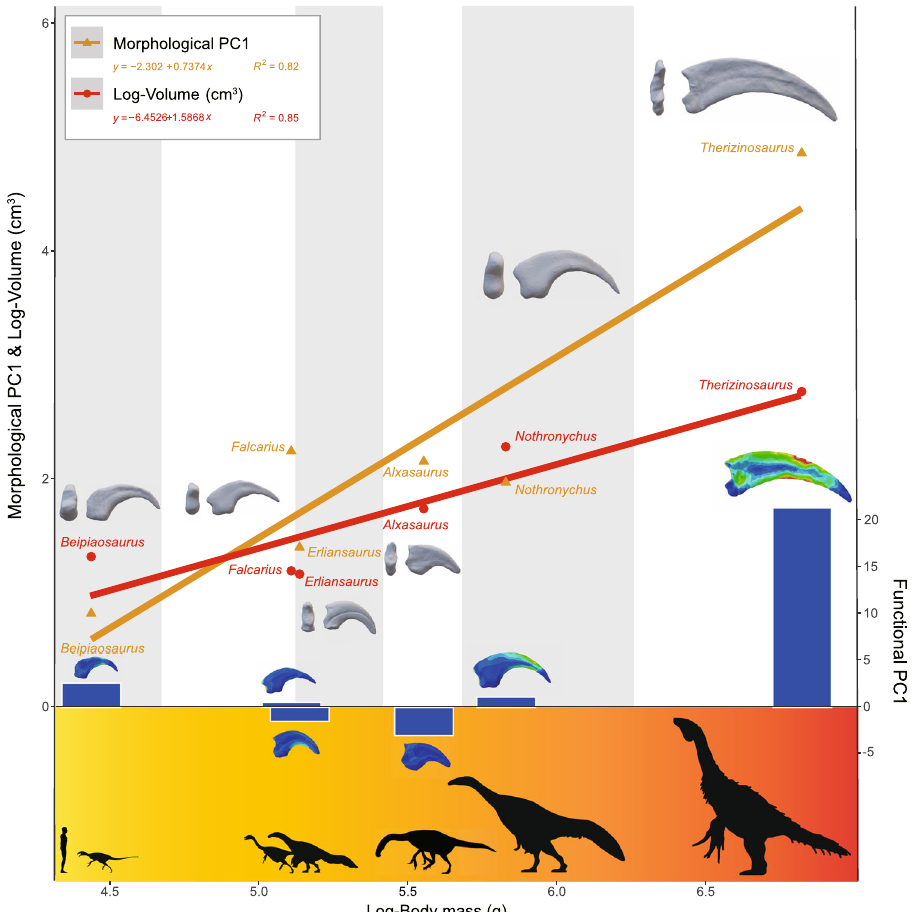
Fig. 5 Linear regressions of morphologies, functional performances and ungual sizes vs. body size of therizinosaurians. Histogram of functional performance showing divergent evolutionary paths of unguals from late gigantic